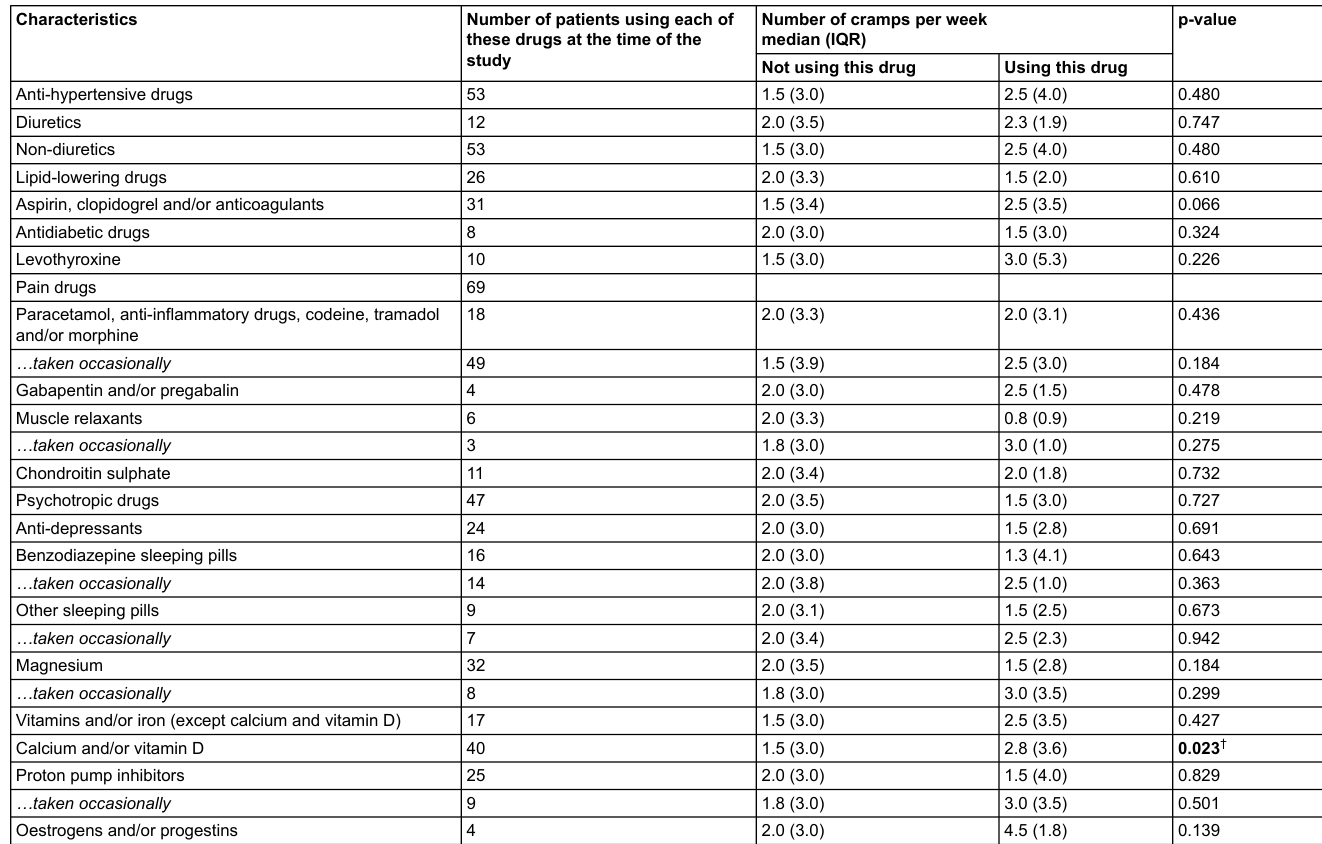
Table S1: Current drug treatment, and number of cramps per week (n = 129) * ; this table compares the median number of cramps per week in patients using and not using the drug in question.